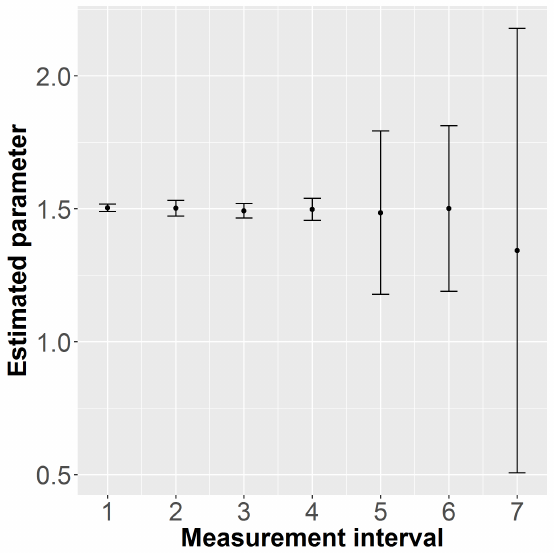
Figure 1. Estimated parameters, with standard deviation, plotted against the observation timestep (number of years between two measurements).